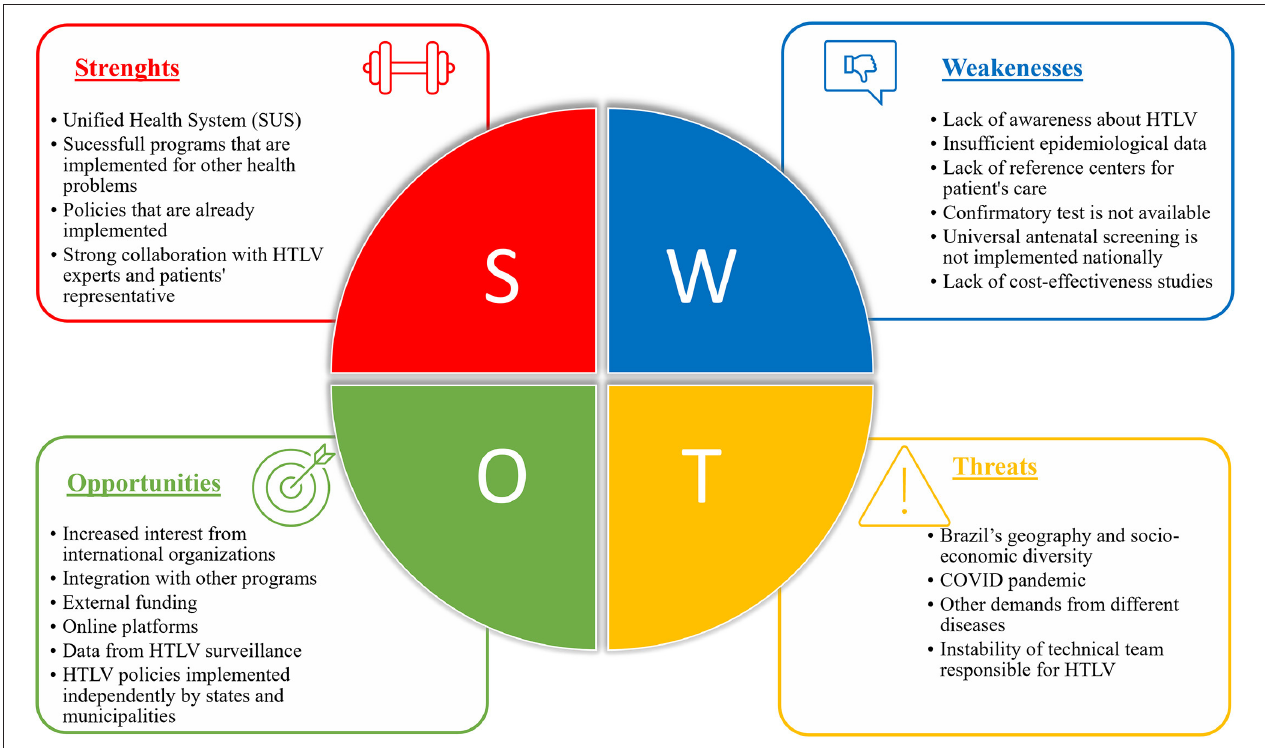
FIGURE 1 | SWOT analysis of the implementation of public policies for HTLV in